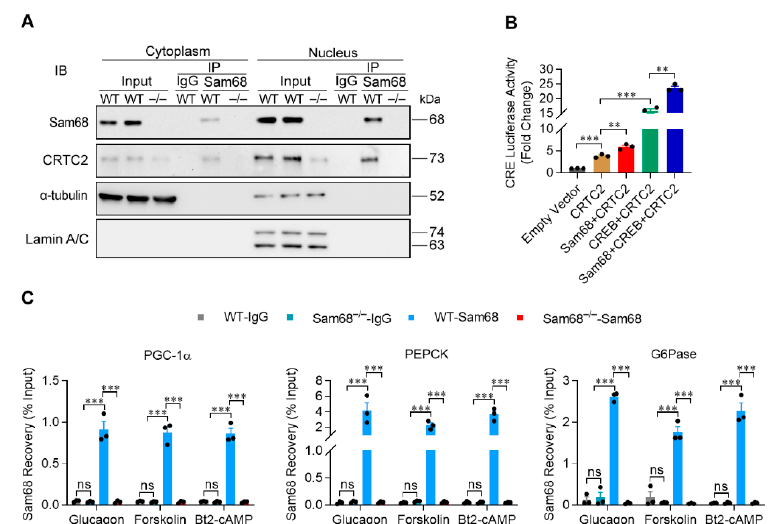
Figure 3. Sam68 interacts with CRTC2 in the nucleus, enhances CREB/CRTC2 transactivity, and co- occupies on the CRE motif in the promoters of gluconeogenic genes. ( A ) WT and Sam68 –/– primary hepatocytes were treated with glucagon (100 nM) for 30 min, then their nuclear and cytoplasmic fractions of proteins were isolated; Sam68 protein in each fraction was co-immunoprecipitated, and CRTC2 protein in the precipitates was detected by immunoblotting. ( B ) Plasmids coding for CRE-containing promoter-driven firefly luciferase expression and CMV promoter-driven renilla expression were co-transfected with different combinations of pcDNA3-HA (Empty), pcDNA3-HA- Sam68, pcDNA3-Flag-CRTC2, and/or pCF-Flag-CREB plasmids in HepG2 cells; 48 h later, luciferase activity was measured and normalized to renilla activity. n = 3. ( C ) WT and Sam68 –/– hepatocytes were treated with glucagon (100 nM), forskolin (10 μ M), or Bt2-cAMP (100 μ M) for 30 min; then, Sam68 occupancy on the CRE motif of promoters for PGC-1 α , PEPCK, and G6Pase were evaluated via ChIP assay. n = 3. Data are expressed as mean ± s.e.m. ** p < 0.01, *** p < 0.001, ns, not significant (( B , C ): two-way ANOVA).